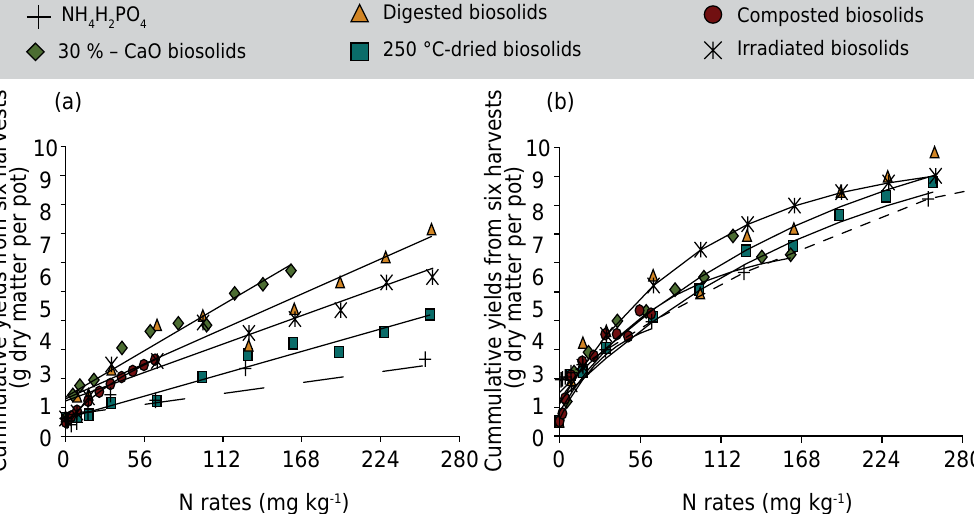
Figure 4. Cumulative yields in responses to biosolids-N application and to NH 4 H 2 PO 4 + basal application in Spodosol (a) and Oxisol